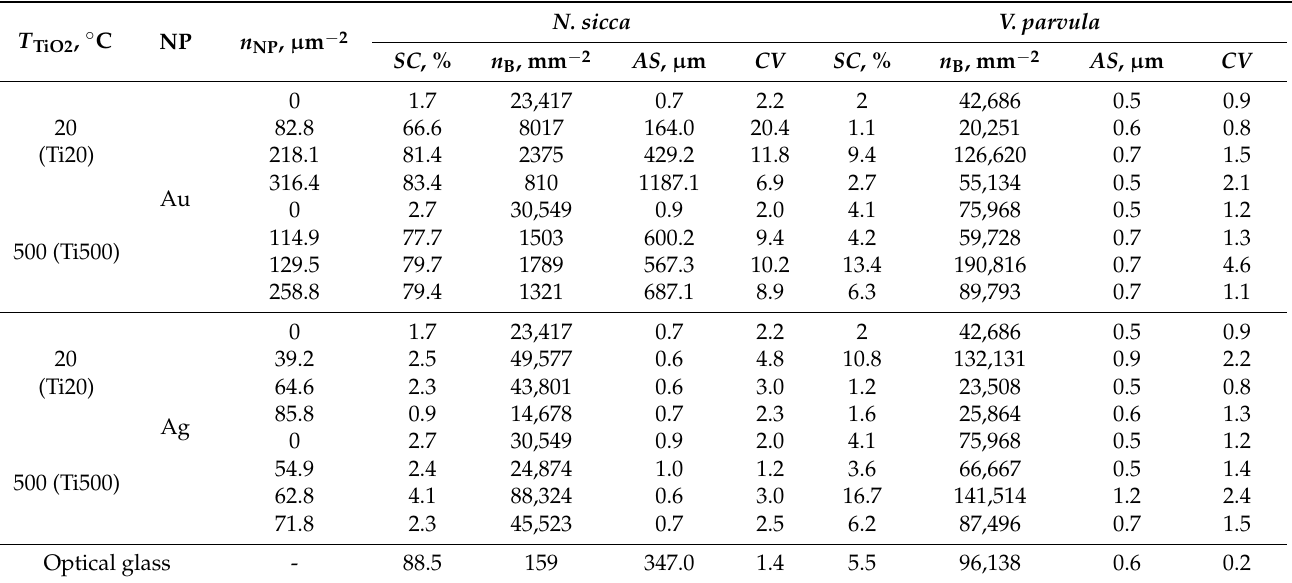
Table 2. Parameters describing the growth of N. sicca and V. parvula bacteria: n NP —density of NP; SC —surface coverage; n B —density of bacteria cells; AS —average size of bacteria colonies; and CV —coefficient of variation of clusters size.